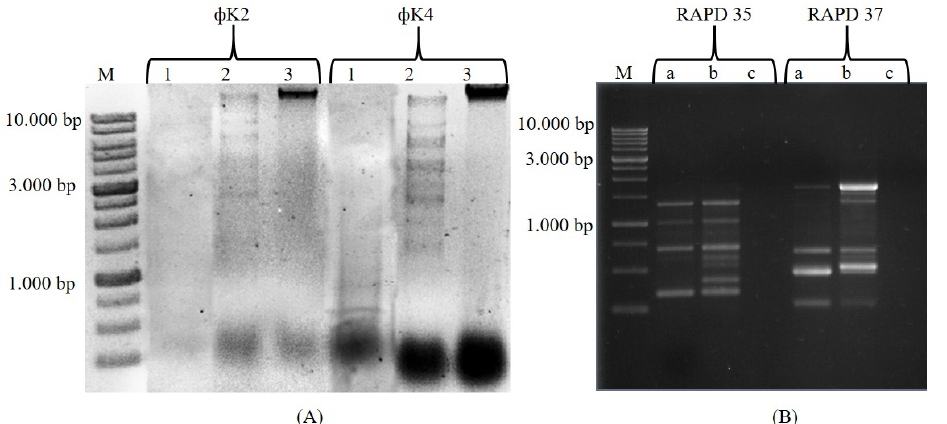
Figure 2. Profile RFLP and PCR RAPD. ( A ) RFLP pattern; M: marker, 1: Sau 3AI, 2: Hind III, 3: un-digested. ( B ) Amplification PCR RAPD; a: Φ K2, b: Φ K4, c: control negative.